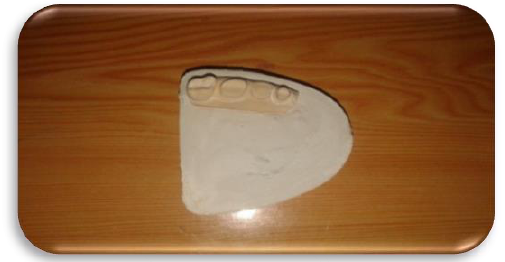
Figure 3: crowns and bridges seated on their respective stone model.